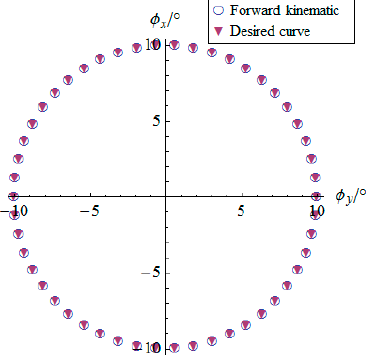
Figure 13. Angular displacement of the mobile platform.